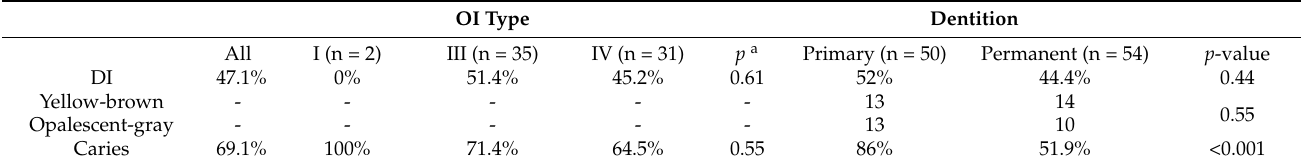
Table 2. Prevalence of dentinogenesis imperfecta and caries in OI patients.